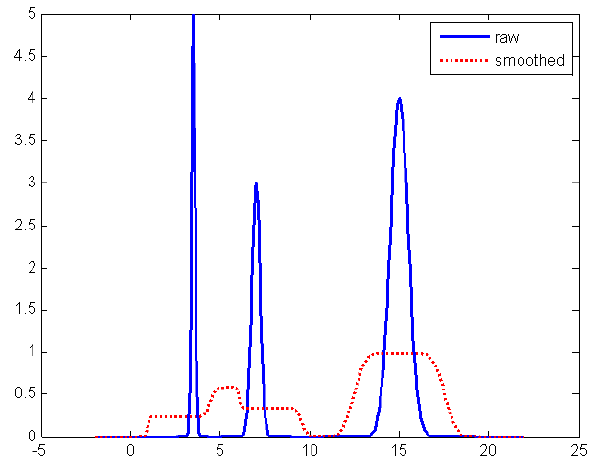
Figure 1. The effect of running average on close peaks. Around 5 a spurious peak (‘ghost’) appears although the original signal showed a minimum in this zone. These effect may affect both temporal and spatial averages, for example when small clouds are detected.